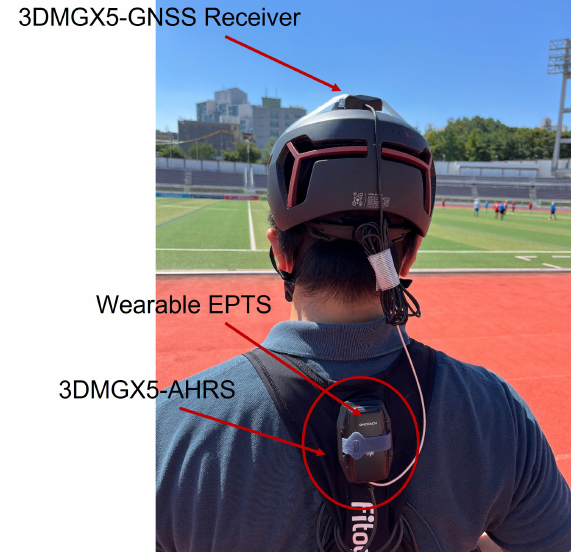
Figure 14. The athlete wearing the wearable EPTS of football player and 3DM-GX5 GNSS/IMU AHRS. First, the athlete wearing the wearable EPTS spurted straight for 7 s. The athlete’s speed increased to 8 m · s − 1 . Figures 15 and 16 show the planar trajectory of the athlete and the expansion of the trajectory of the athlete, respectively. The blue dots represent the measured GNSS trajectory and the red dots represent the trajectory estimated using the result is much smoother than the GNSS trajectory, and provides more position data.